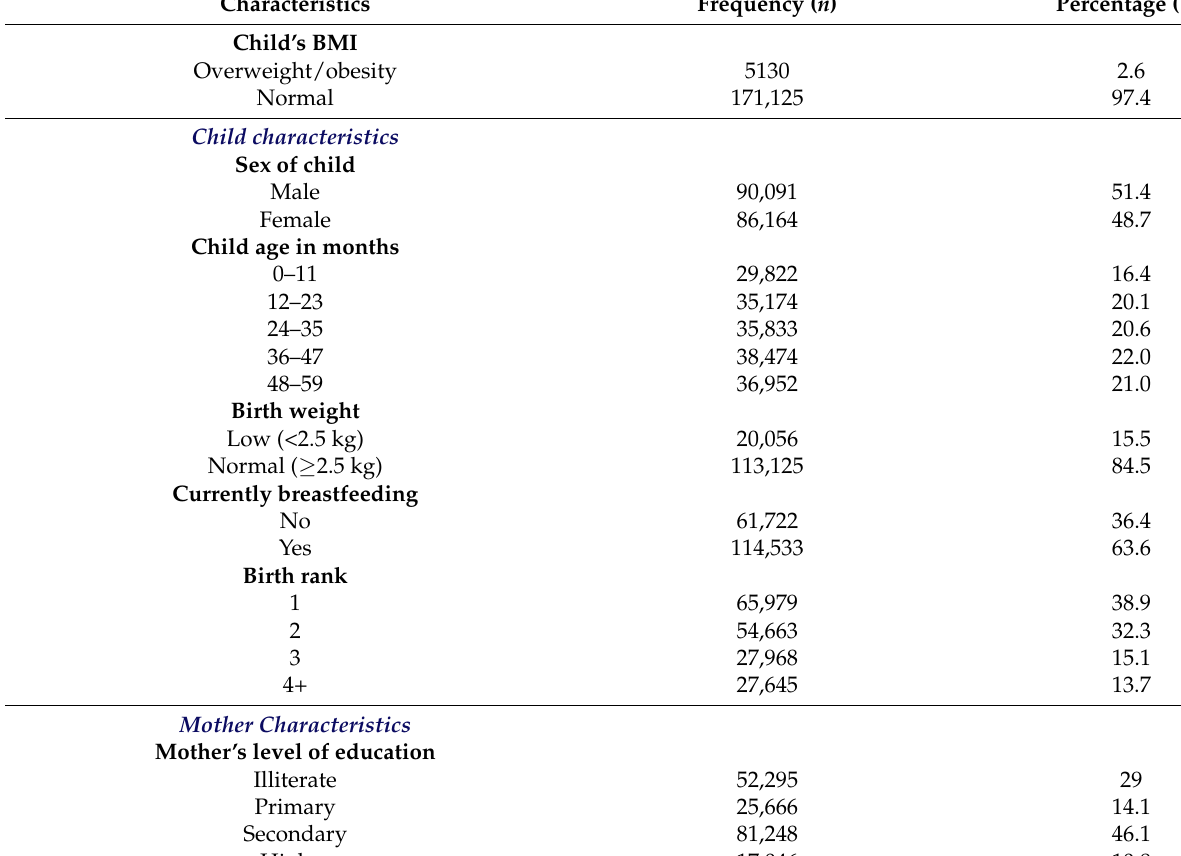
Table 1. Sociodemographic and household characteristics ( n =